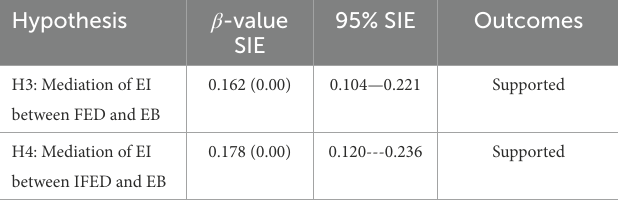
TABLE 6 Hypothesis testing for